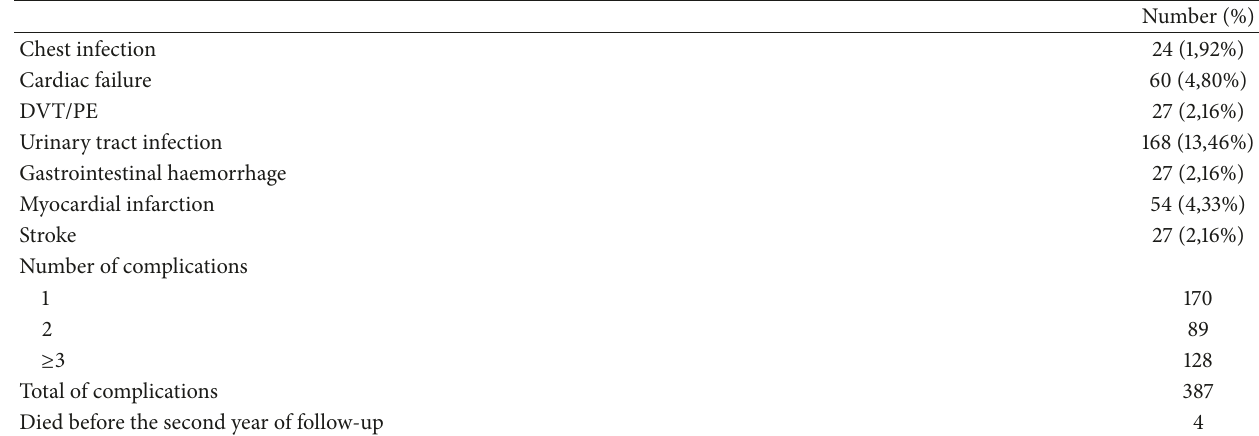
Table 3: Number of perioperative complications.